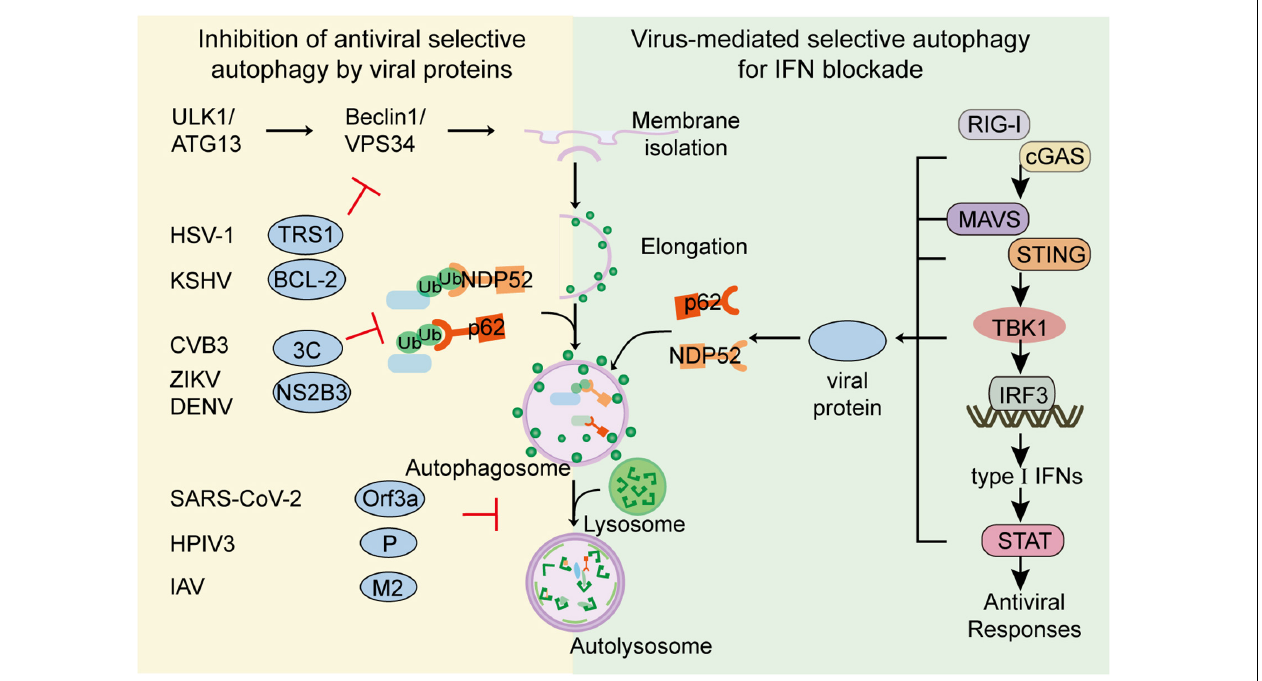
FIGURE 2 | Viral evasion against selective autophagy. To escape the restriction of selective autophagy, viruses have evolved multiple strategies to subvert selective autophagy. Viruses such as CVB3, DENV could directly cleave cargo receptors. Viruses such as HSV-1 or KSHV could inhibit autophagy activation through ATG proteins. Viruses such as SARS-CoV-2 and IAV could restrict the fusion of autophagosome and lysosome for their replication. Additionally, to optimize replication capacity, viruses including H7N9, SARS-CoV-2 and BTV, could also utilize selective autophagy to minimize host antiviral responses. Viruses such as HSV-1, H7N9, and SARS-CoV-2, could utilize cargo receptors to target IFN signal molecules for autophagic